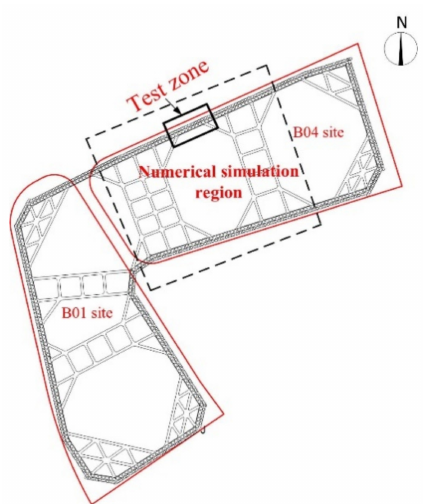
Figure 1. Schematic diagram of the excavation plane position in the field test.